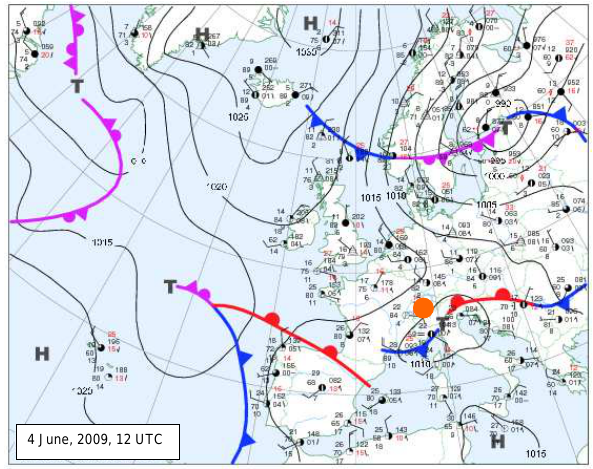
Fig. 5. Synoptic situation above Europe (surface), 4 June 2009, at 12:00UTC. Area of interest is shown with an orange